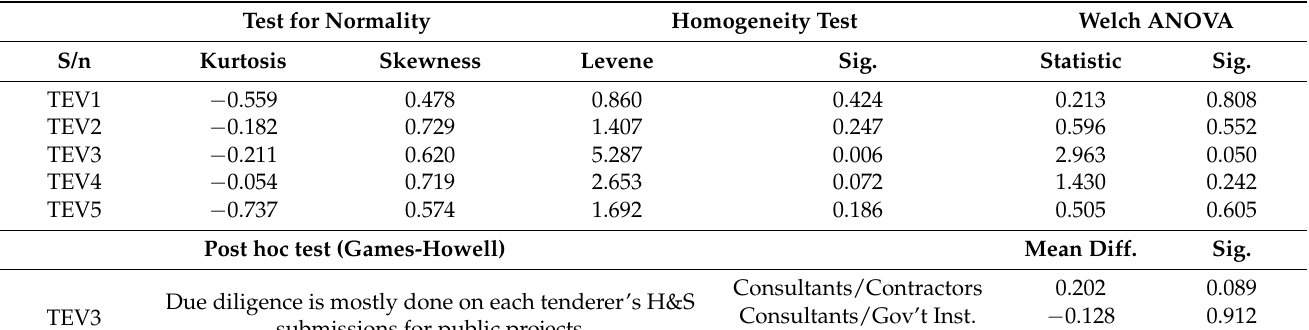
Table 9. One-way ANOVA for H&S considerations in tender